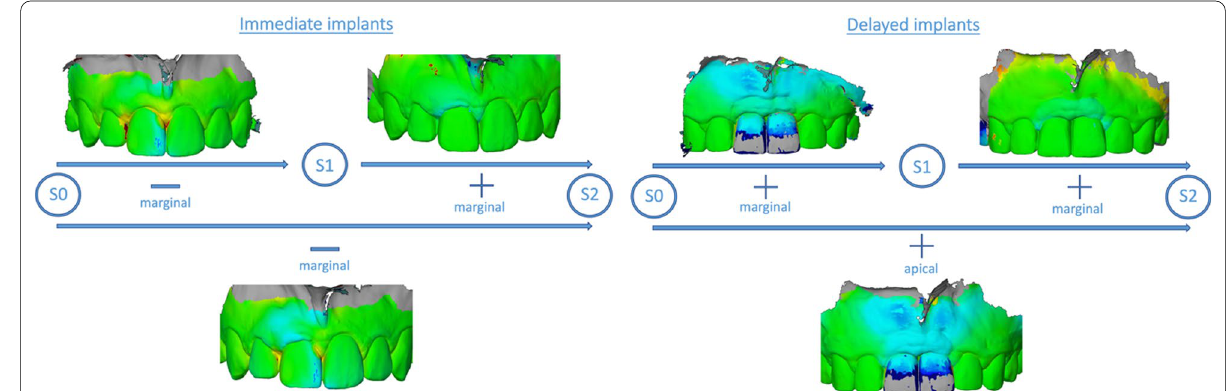
Fig. 4 Volumetric tissue changes after 6 (S0–S1) and 12 (S0–S2) months, and comparing baseline with 12 months (S0–S2). A Immediate implantation group, B delayed implantation